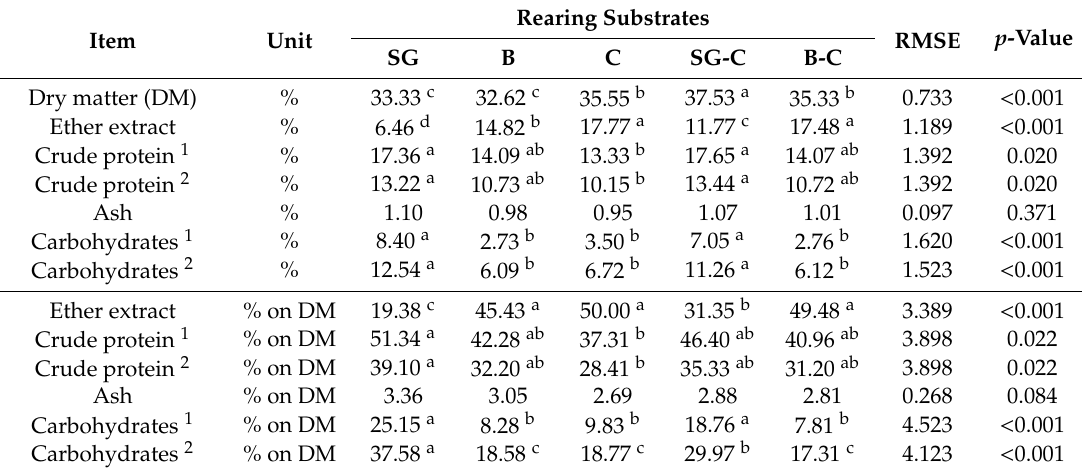
Table 2. Proximate compositions of the larvae reared on the di ff erent